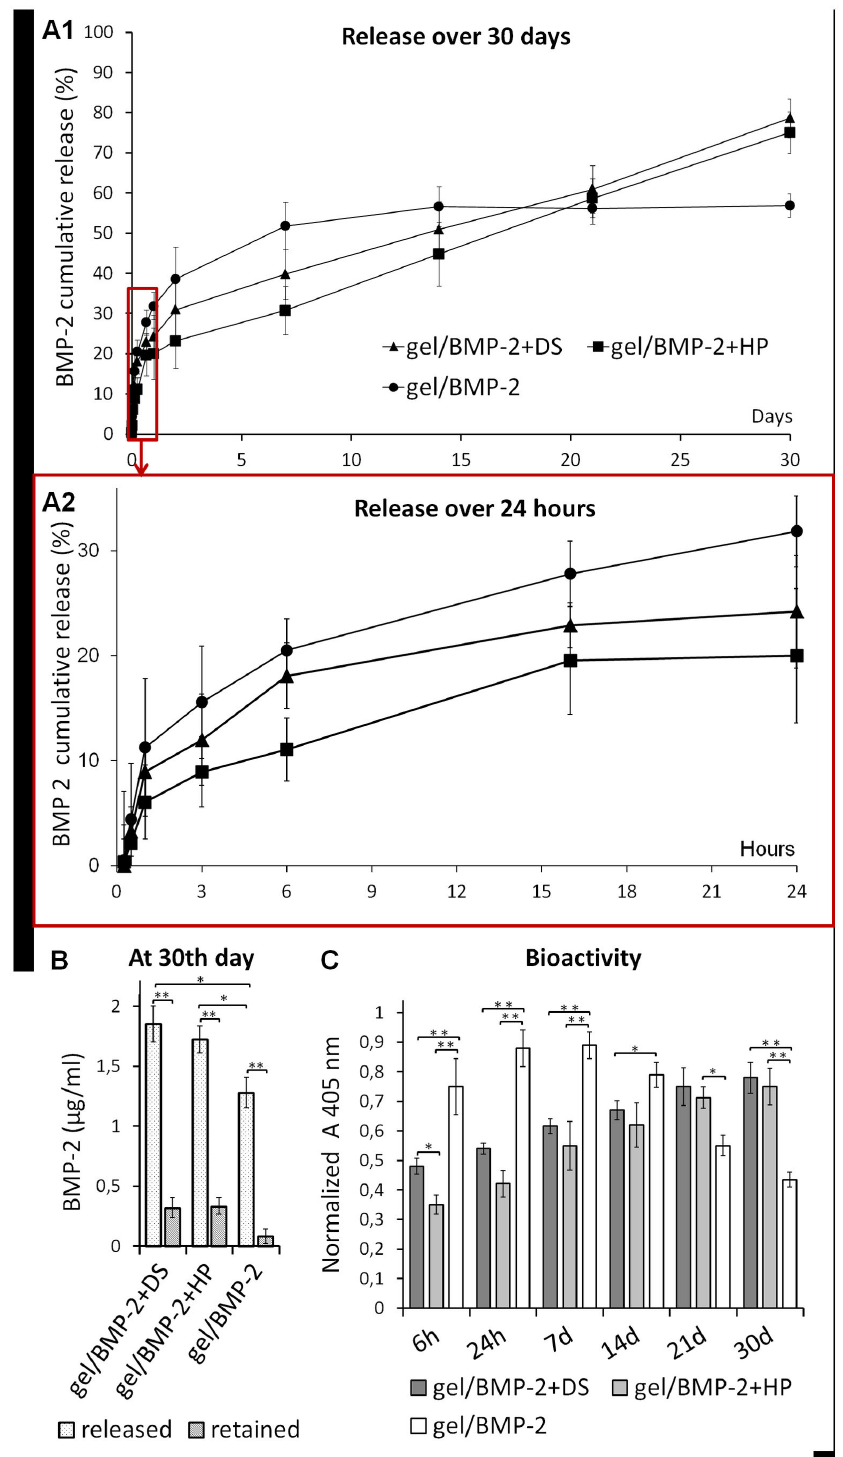
Figure 1. In vitro release of BMP-2 from gel/BMP-2+DS, gel/BMP-2+HP and gel/BMP-2 over 30 days (A1) and over 24 h (A2). The amount of BMP-2 measured by ELISA is shown as the cumulative release normalized to the control release. (B) BMP-2 released/retained from the constructs after 30 days. (C) The bioactivity of BMP-2 released over 30 days as assessed by the ALP activity of myoblast cells. The values represent the mean ± SD (n=3). Error bars represent the SD (n=3); *p<0.05 and **p<0.01. doi: 10.1371/journal.pone.0078551.g001 PLOS ONE |